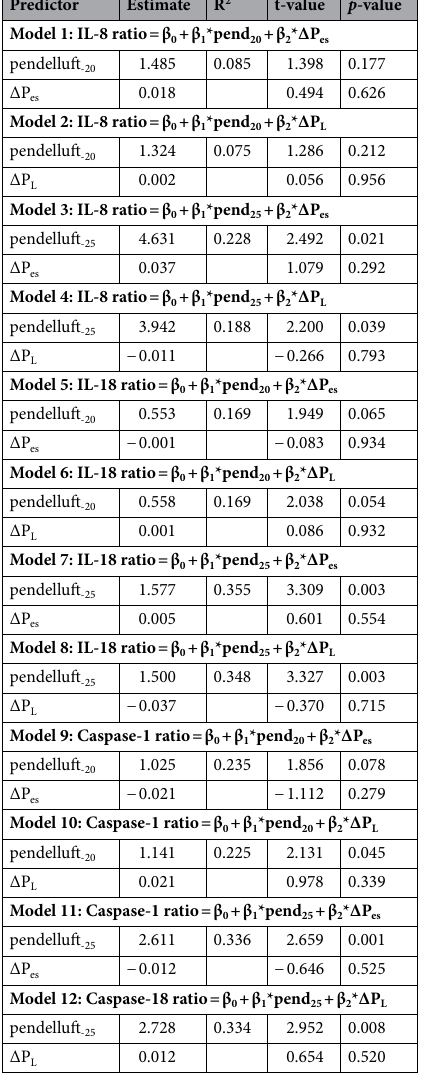
Table 2. Effect of ΔP es and ΔP L on associations between pendelluft 20-25 frequencies and biomarker ratios. Pendelluft -20 and pendelluft -25 represent the pendelluft frequency at magnitudes of − 20% and − 25%, respectively. ΔP es : negative deflection of esophageal pressure (P es ) from the onset of inspiratory effort during the ventilatory cycle; ΔP L , tidal change in transpulmonary pressure, calculated as airway pressure (P aw) minus P es , between the maximum and minimum values of the ventilatory cycle; V T (mL/kg PBW): tidal volume measured in mL/kg of predicted body